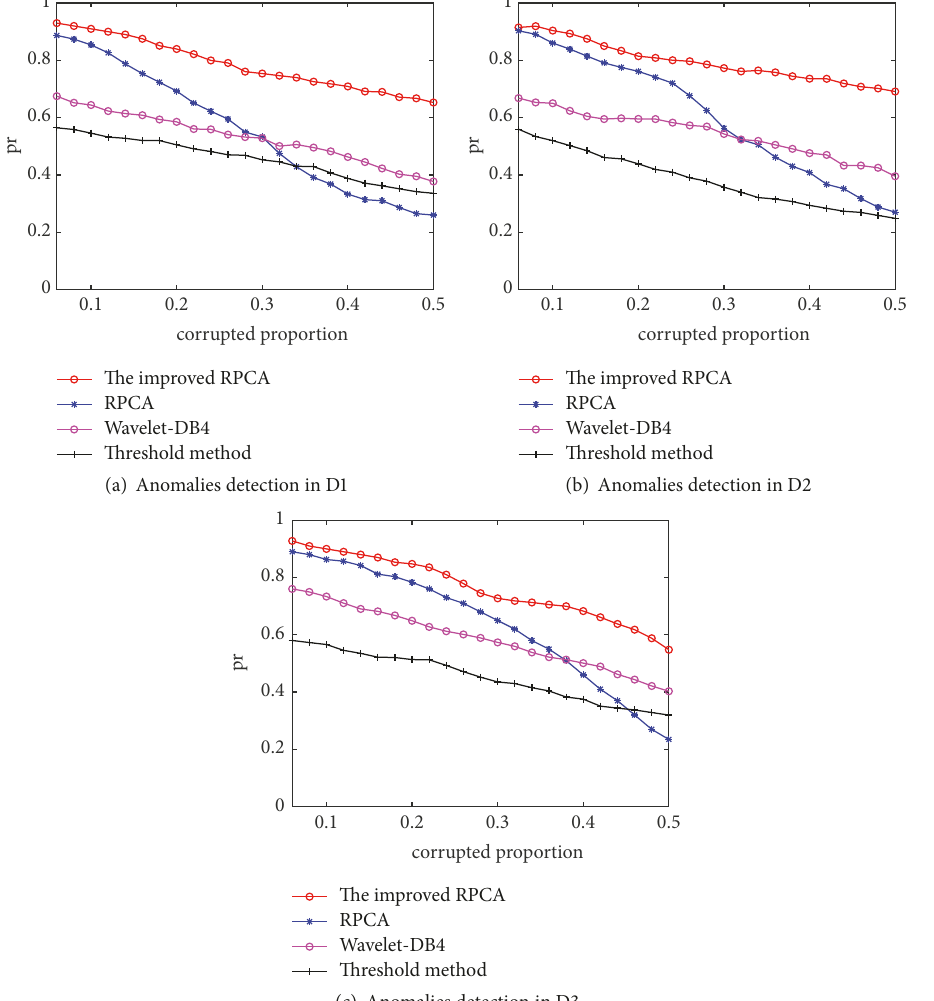
Figure 4: Performance of anomalies detection in three ground truth datasets.